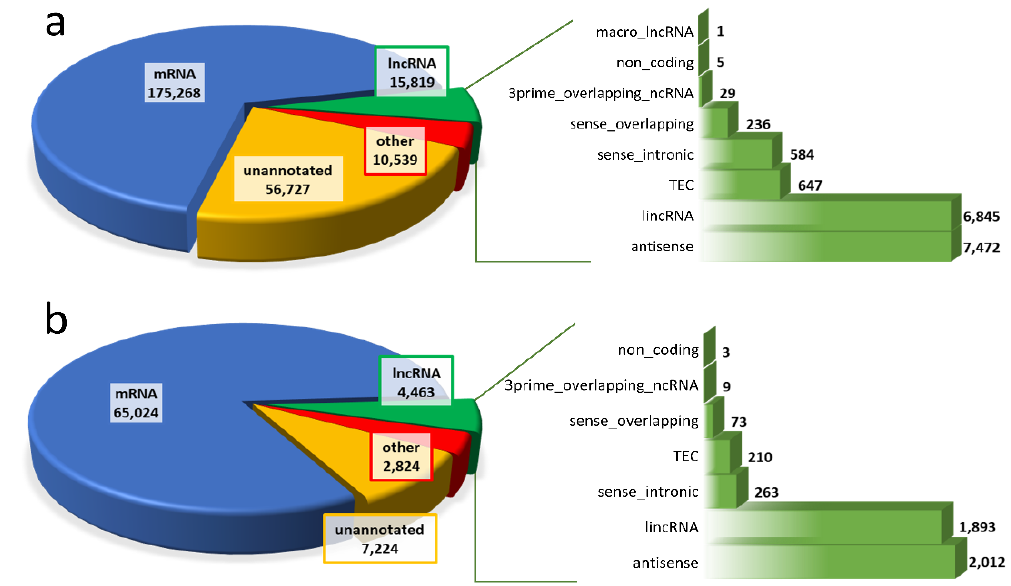
Figure 2. Classification of the assembled human placental transcripts according to their Ensembl code class (pie graphs) detailing lncRNA distribution (bar graphs) of: ( a ) all expressed loci; ( b ) transcripts with expression value (fragments per kilobase of transcript per million mapped reads, FPKM) higher than 1.